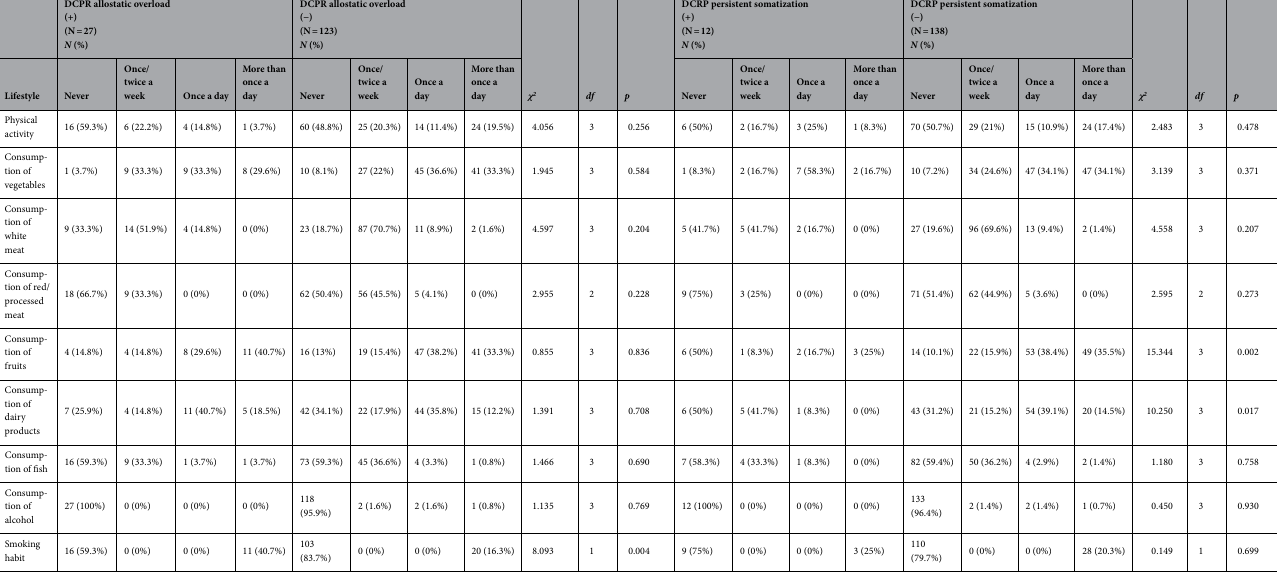
Table 3. Associations between DCPR allostatic overload, persistent somatization and lifestyle-related habits. (+) Syndrome present; (−) Syndrome absent, DCPR diagnostic criteria for psychosomatic research.